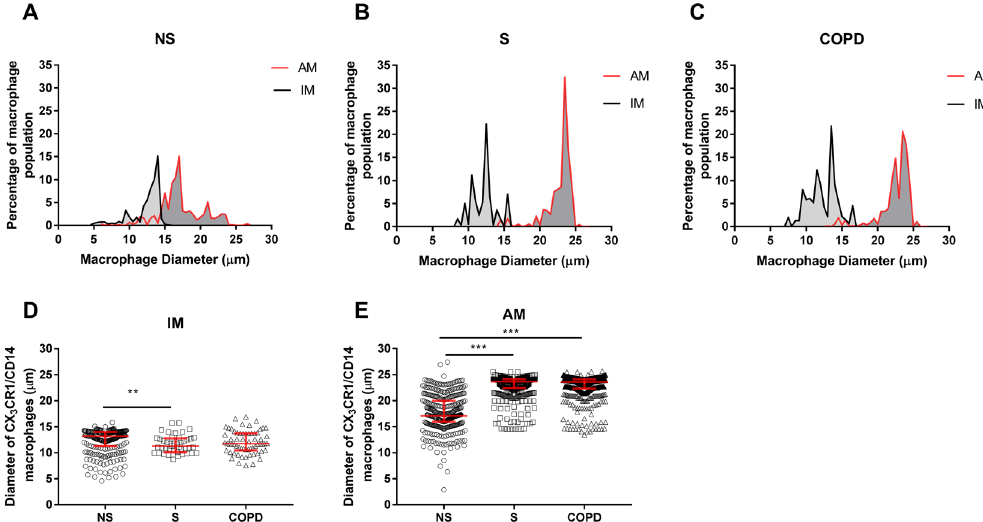
Figure 5. The diameter of alveolar and interstitial macrophages in lung resected tissue. Alveolar (AM) and interstitial (IM) macrophages from never smokers (NS) (n = 11) ( A ), smoking controls (S) (n = 15) ( B ) and COPD patients (COPD) (n = 12) ( C ) were identified in FFPE resected lung tissue by co-expression of CX 3 CR1 and CD14 and the diameter of each cell was measured. Data are shown as the percentage of macrophage population measuring a certain diameter ( A - C ) or individual cell diameters for IMs ( D ) and AMs ( E ) with median and interquartile range. Mann-whitney t-tests were performed between IM and AMs. One way ANOVA followed by Tukey-Kramer Multiple Comparisons Test were performed between subject groups. ** , *** Significant difference (p < 0.01, < 0.001